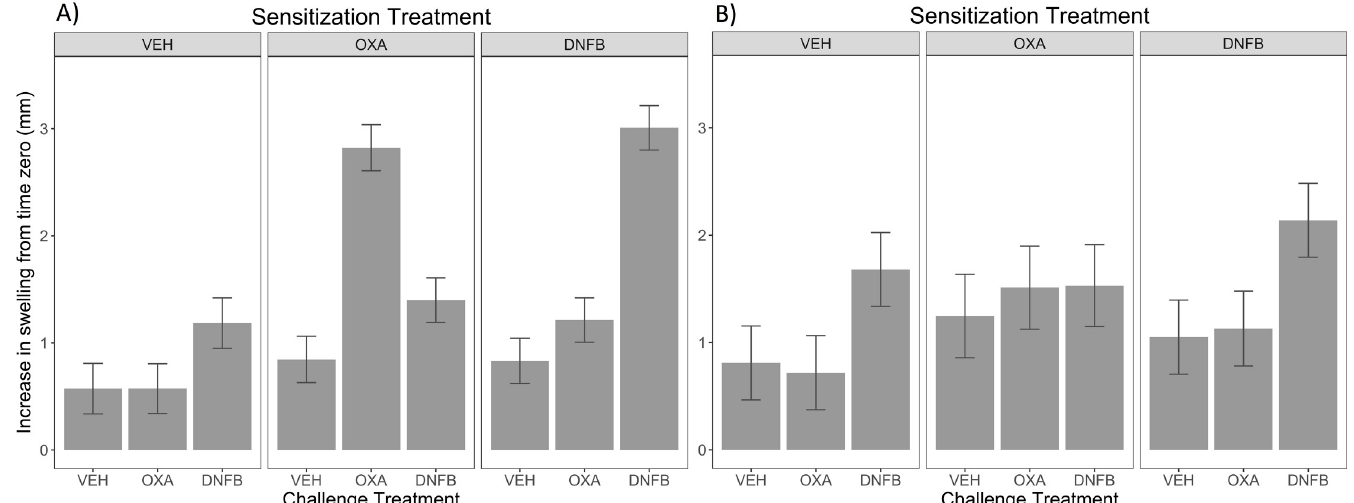
Fig 1. Ear thickness shows hapten-specific ear inflammation response in ears of pigs for 32 day sensitization but not for 5 day. Pigs were sensitized by intradermal injection on the back with DNFB, OXA, or 1:1 acetone:olive oil vehicle alone as indicated at the top of each graph. Animals were challenged by intradermal injection in the ear either A)32 or B)5 days after sensitization with the indicated ear treatment. Data shown is from the 48 hour time point, and is reported as the LS means difference in ear thickness (mm) from time zero, pre-sensitization. The interaction of back sensitization � ear treatment was evaluated for significance to provide evidence for hapten-specific memory. With a threshold p-value < 0.05, 32 day (p-value < 0.01) sensitization period showed evidence of hapten-specific ear swelling, while the 5 day sensitization period (p-value < 0.98) did not. Error bars represent standard error.